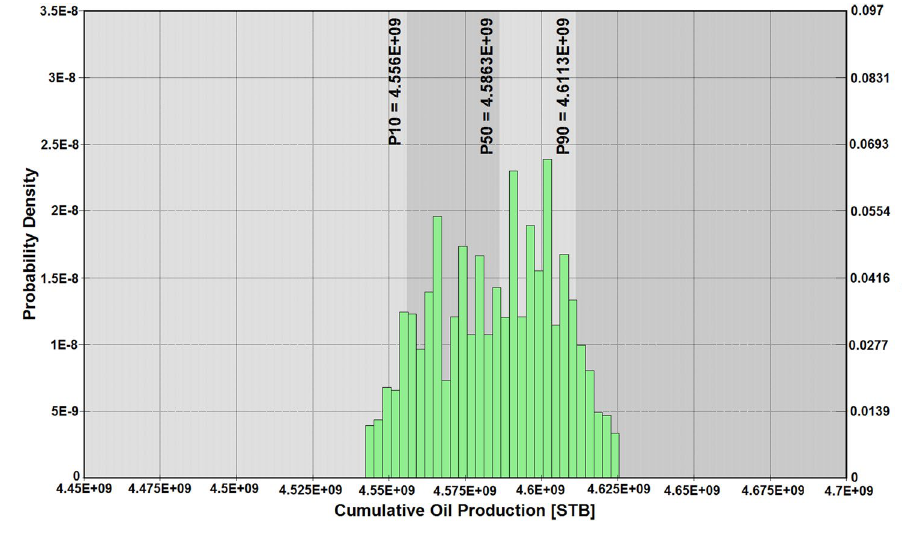
Fig. 14 Cumulative distribu-